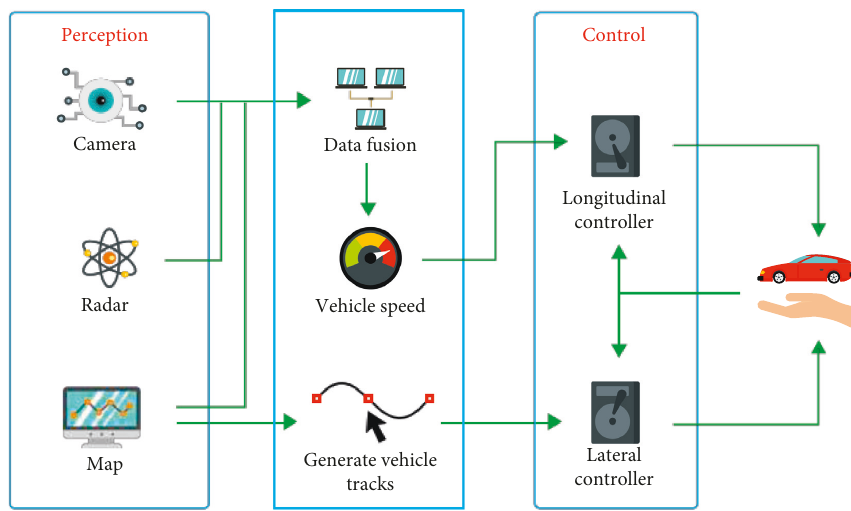
Figure 1: Autonomous vehicle control